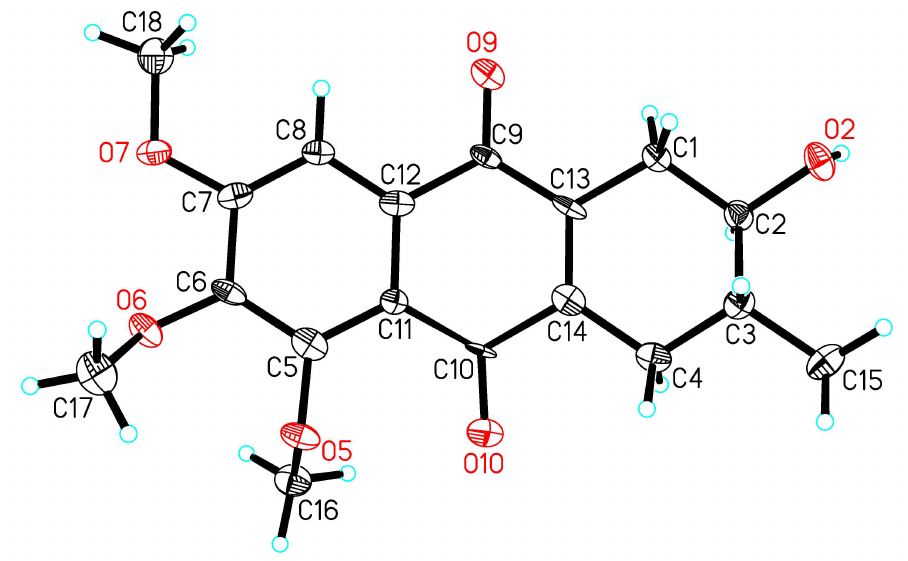
Figure 4. X-ray crystal structure of compound 1 .